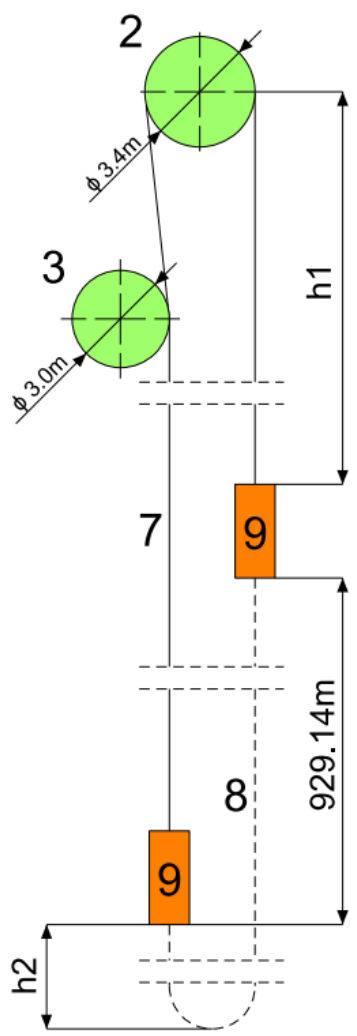
Figure 2. Schematic diagram of the Budryk shaft hoisting machine, 1—hoist frame (tower), 2—Koepe pulley with motor, 3—deflection sheave, 4—separating beam, 5—west part shaft, 6—east part shaft, 7—hoisting ropes, 8—balance ropes, 9—skip cage (installed deadweight), 10—shaft tube with lining, h1 = 49.7 m, h2 = 34.34 m (Figure 2 correspond to Figure 1). Table 3. List of parameters used for calculations.